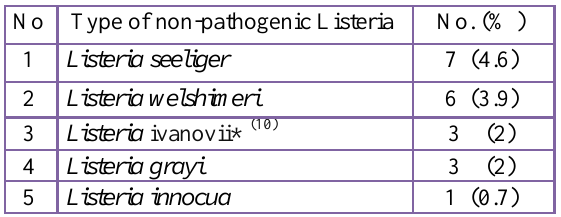
Table 1: The prevalence rate of non-pathogenic listeria in